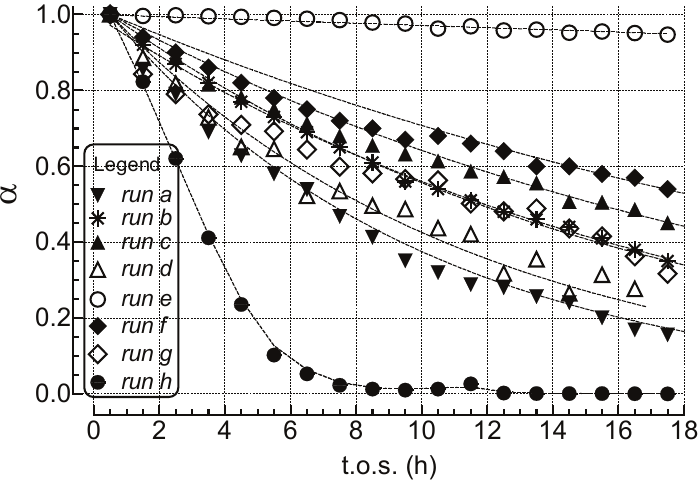
Figure 2. Relative activity vs. t.o.s. at different experimental conditions (see Table